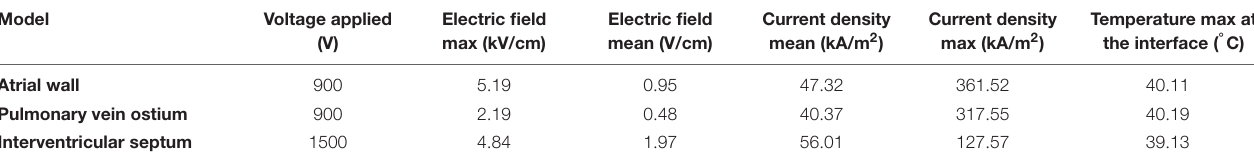
TABLE 2 | Notable results of the electrothermal